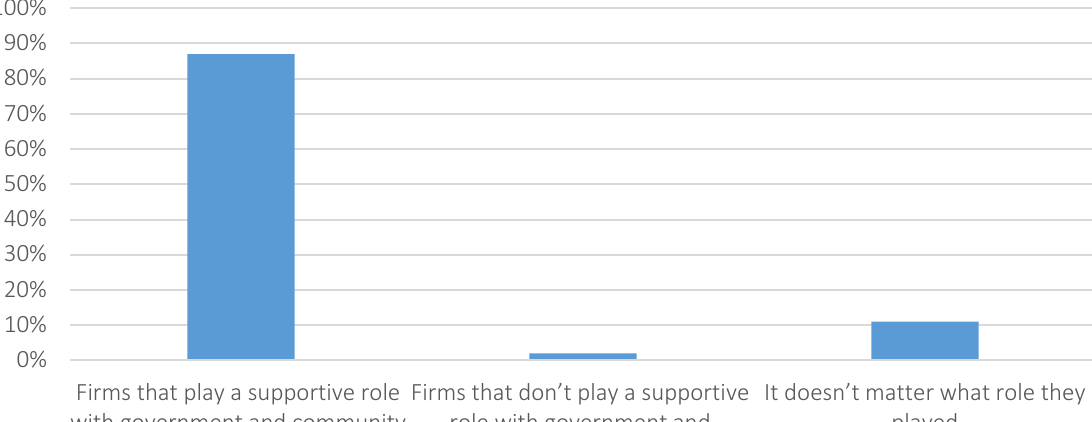
Figure 3. Firms the community can deal with during or after a crisis like